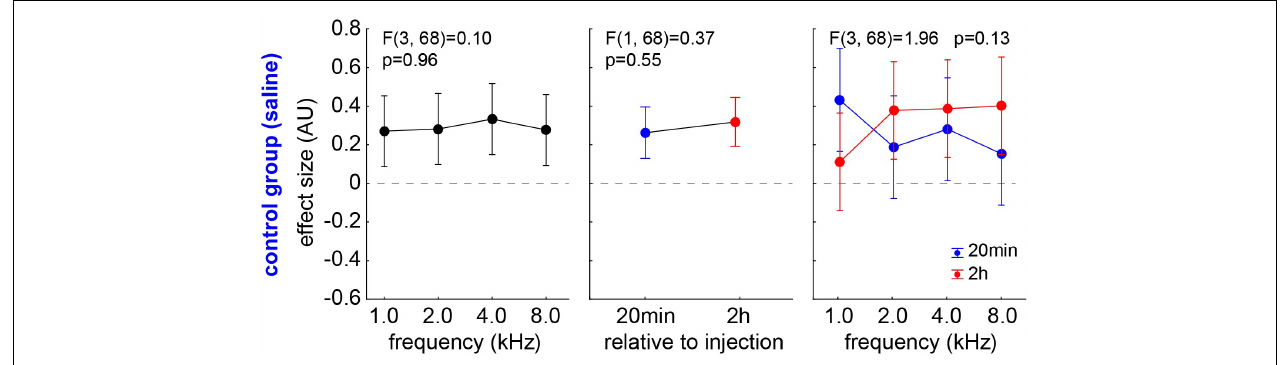
FIGURE 5 | Analysis of effect size (AU) in group C by one-factorial repeated measurement mixed ANOVA with the factor frequency and the repetition factor time . No significant effect can be found in any of the factors.